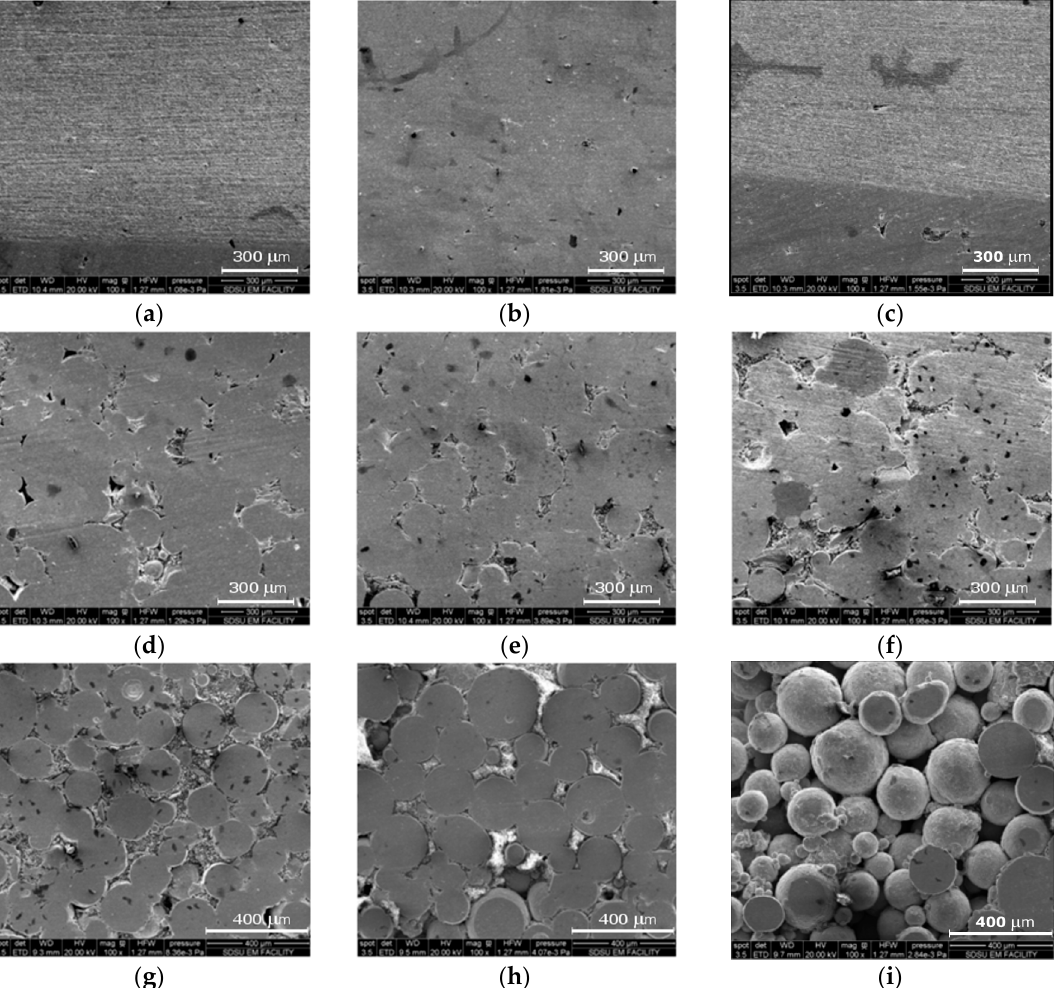
Figure 9. SEM images of selected sintered TNZT samples with varying relative densities. The samples and relative densities of each are as follows: ( a ) 93.8%; ( b ) 89.9%; ( c ) 85.1%; ( d ) 79.1%; ( e ) 73.2%; ( f ) 69.4%; ( g ) 66.0%; ( h ) 59.3% and ( i ) 66.8% (unpolished section).